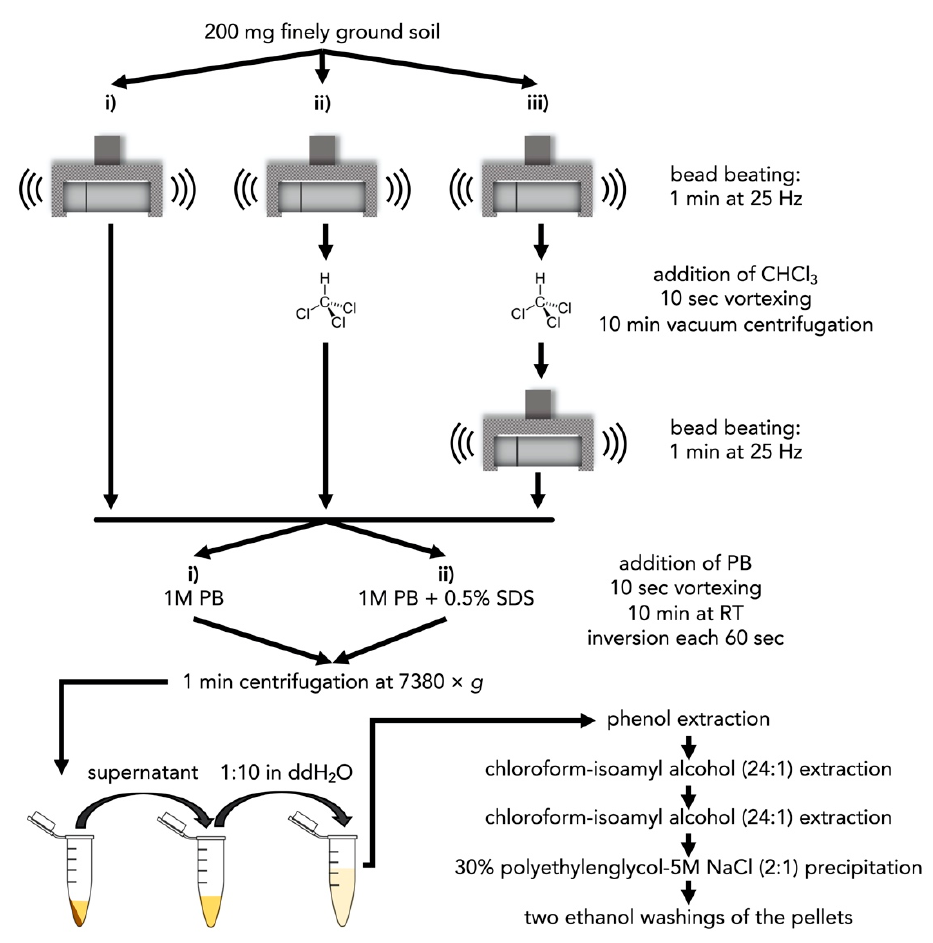
Figure 1. Workflow illustration of preliminary test of different combinations of lysis method and buffer solution. ddH 2 O = double ‐ distilled water; PB = phosphate buffer; RT = room temperature; SDS = sodium dodecyl sulfate.